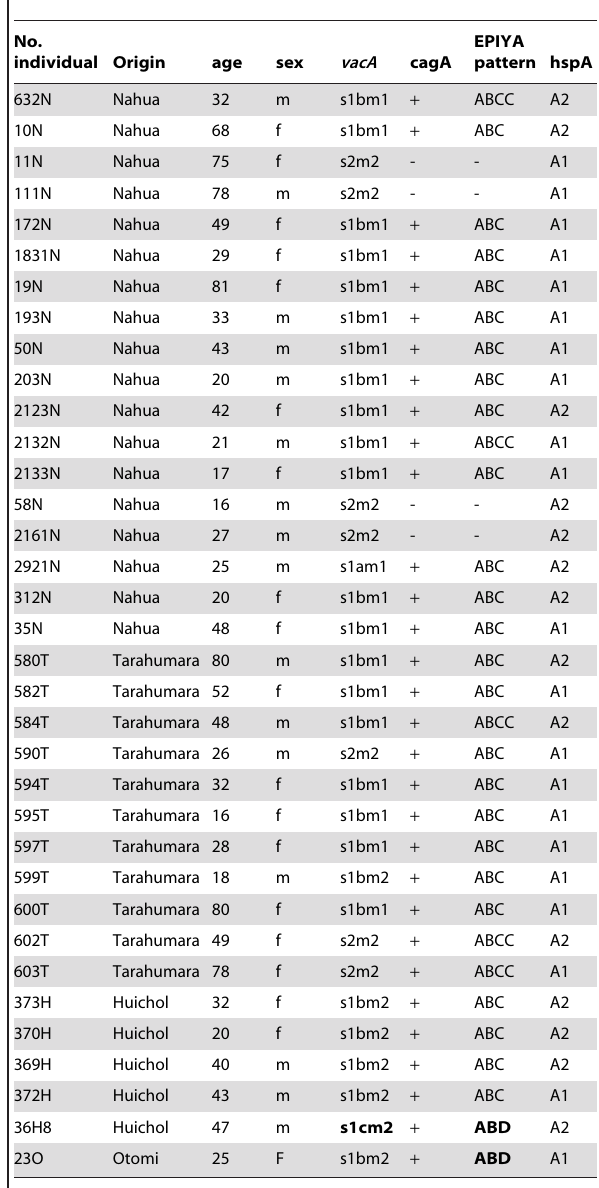
Table 4. Distribution of vacA alleles in H. pylori strains isolated from Mexican indigenous populations.